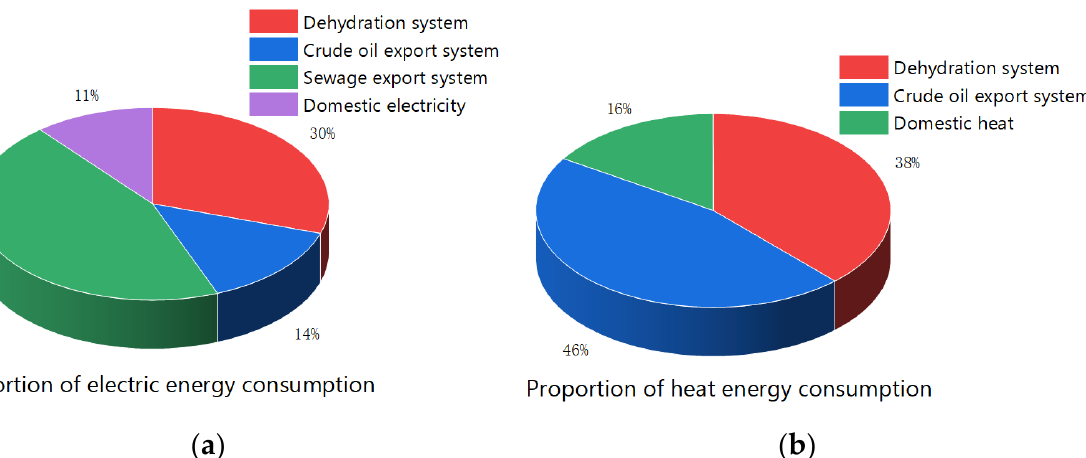
Figure 9. ( a ) Proportion of system electric energy consumption and ( b ) proportion of system heat energy consumption.